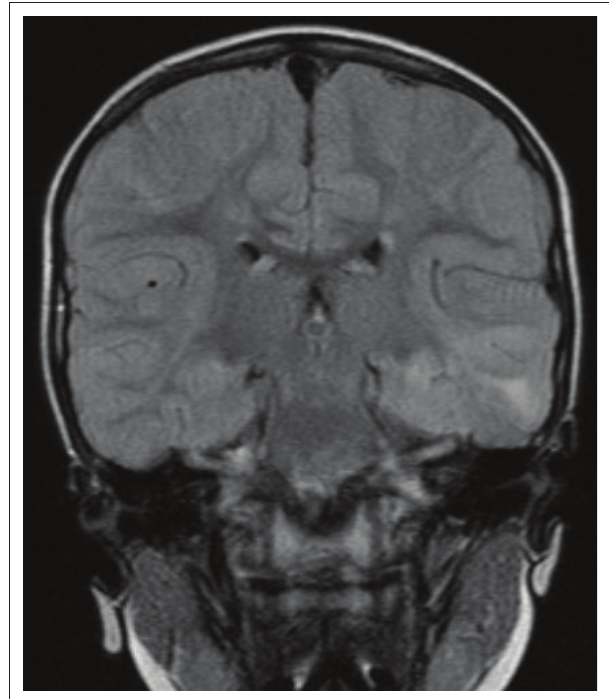
FIGURE 3: Coronal FLAIR MR image.